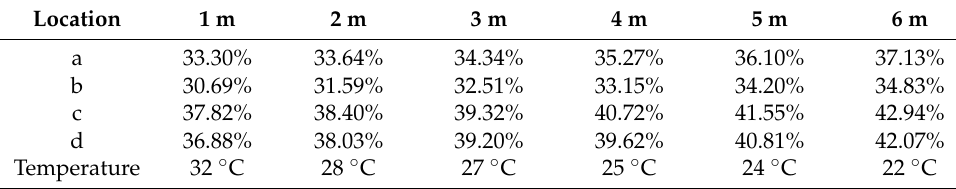
Table 4. Volumetric water content and temperature at drilling